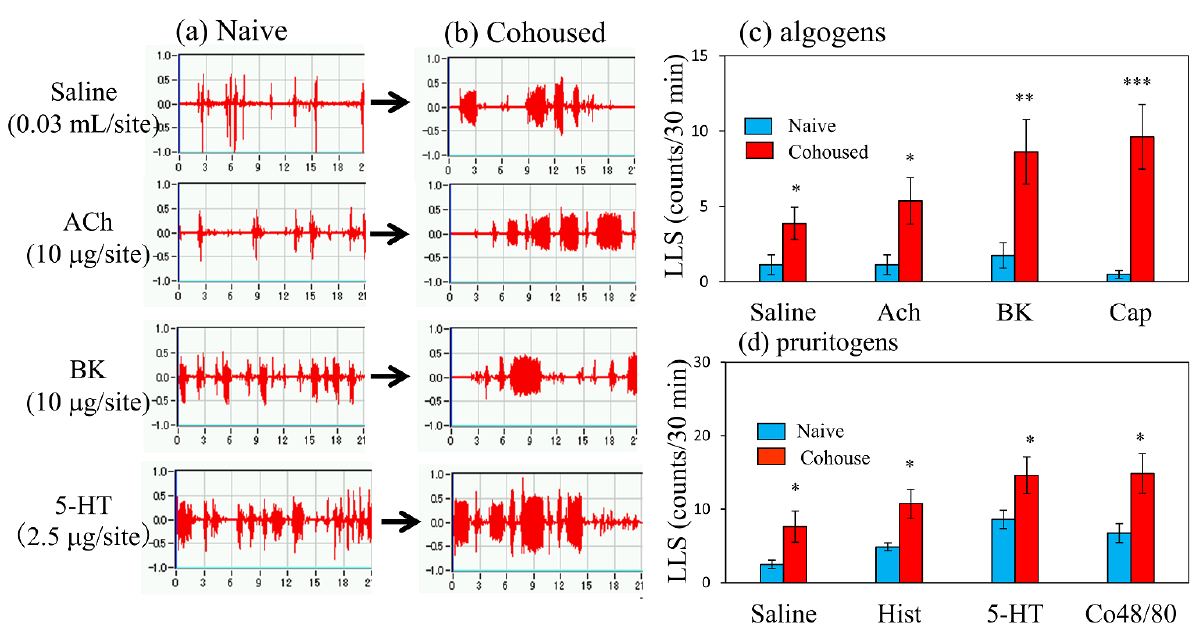
Figure 3. Effects of several algogens or pruritogens on long-lasting scratching (LLS) counts in BALB/c mice cohoused with skin-lesioned NC/Nga mice for 6 days. ( a ) Typical traces of saline-, acetylcholine-, bradykinin-, and serotonin-induced scratching behavior in BALB/c mice with itchy skin induced by cohousing (mite infestation). Traces show the scratching behavior of naïve mice. ( b ) Traces show the scratching behavior of itchy skin induced by mite infestation ( c ) Effects of itchy skin induced by mite infestation on LLS counts induced by saline (0.03 μL/site, intradermal i.d.), acetylcholine (ACh, 10 μg/site, i.d.), bradykinin (BK, 10 μg/site, i.d.), or capsaicin (Cap, 1 μg/site) in mice. ( d ) Effects of itchy skin induced by mite infestation on scratching counts induced by saline (0.03 mL/site, i.d.), histamine (Hist, 10 μg/site, i.d.), serotonin (5-HT, 2.5 μg/site, i.d.), or compound 48/80 (Co48/80, 10 μg/site) in mice. Each value represents the mean ± standard error (S.E.) from six mice (total of 24 mice). * p < 0.05, ** p < 0.01, and *** p < 0.001 compared with the respective values in naïve mice (Student’s t -test).